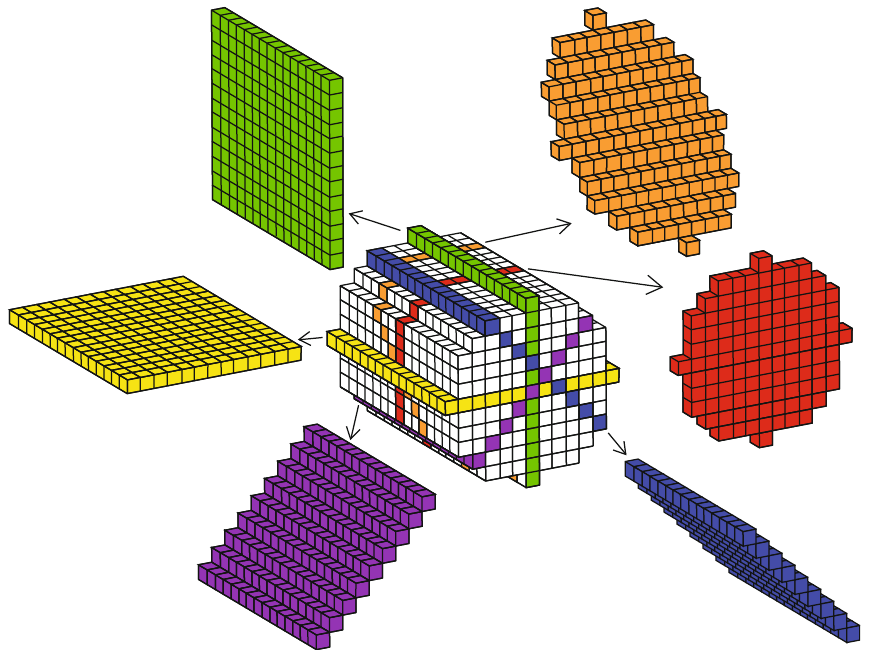
Figure 5: Section with di ff erent cutting